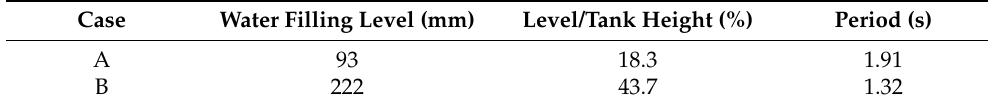
Table 1. Description of test